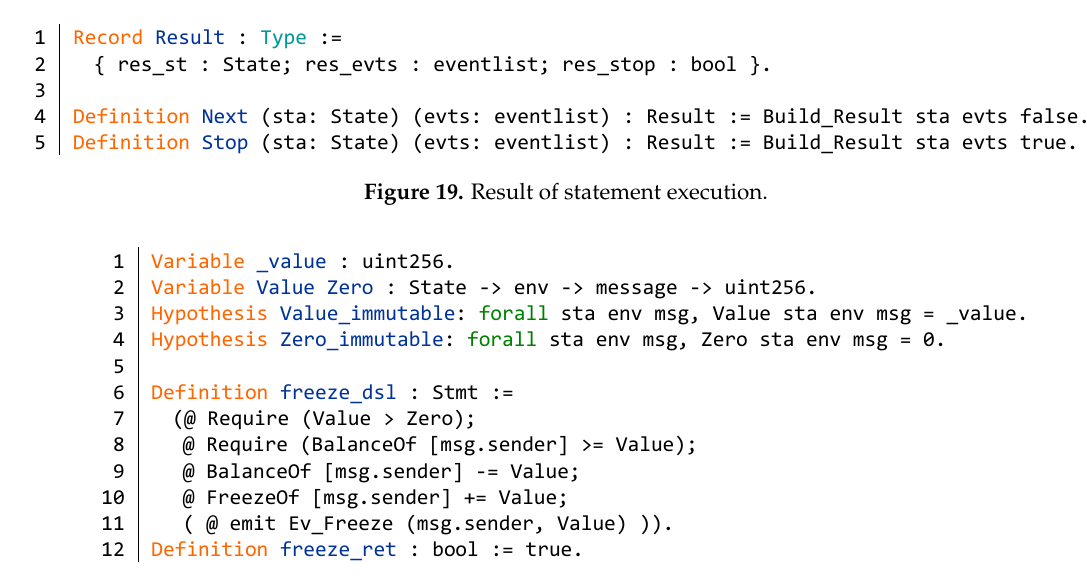
Figure 20. Formal definition of Solidity code of the freeze